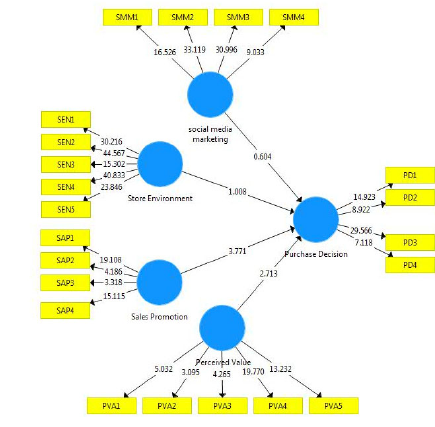
Fig. 3. Hypotheses